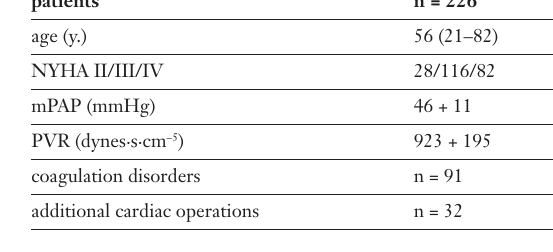
Patient characteris- tics (Mainz, 1/1995 – 3/2005).